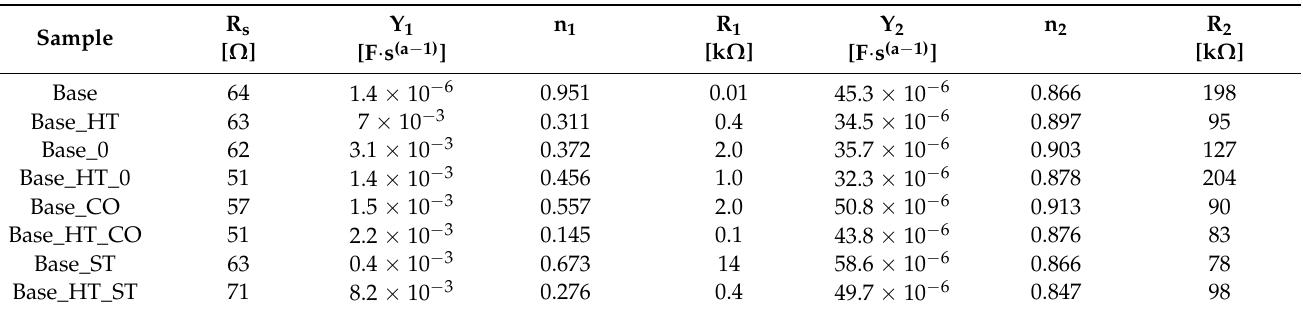
Table 5. Impedance parameters of CoCrMoW alloy with and without heat treatment for two different filler